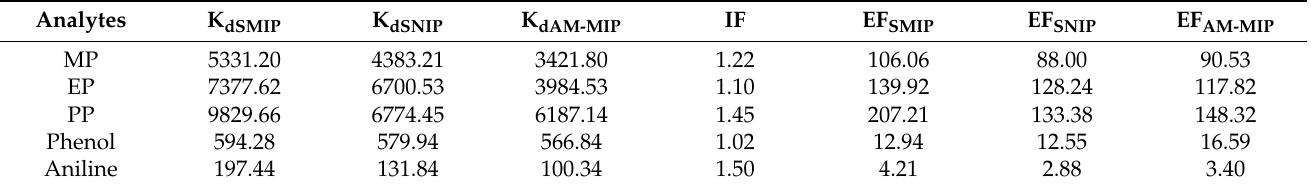
Table 2. Distribution coefficients (K d ), imprinting factor (IF), and enrichment factor (EF) calculated from the selectivity study.